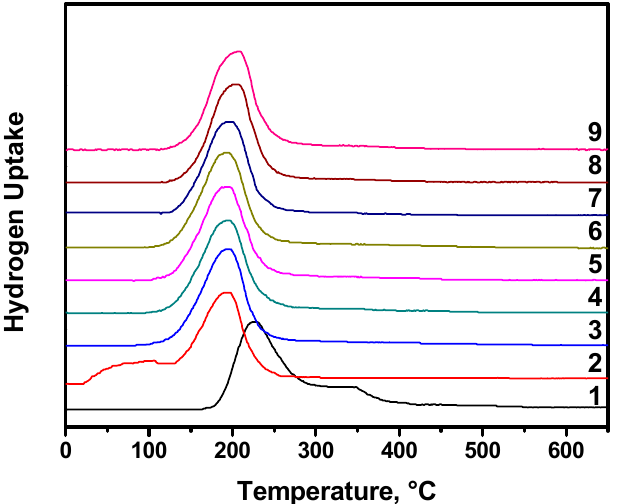
Figure 5. TPR profiles for the Cu-Mg-O system registered in nine consecutive reduction/oxidation cycles.